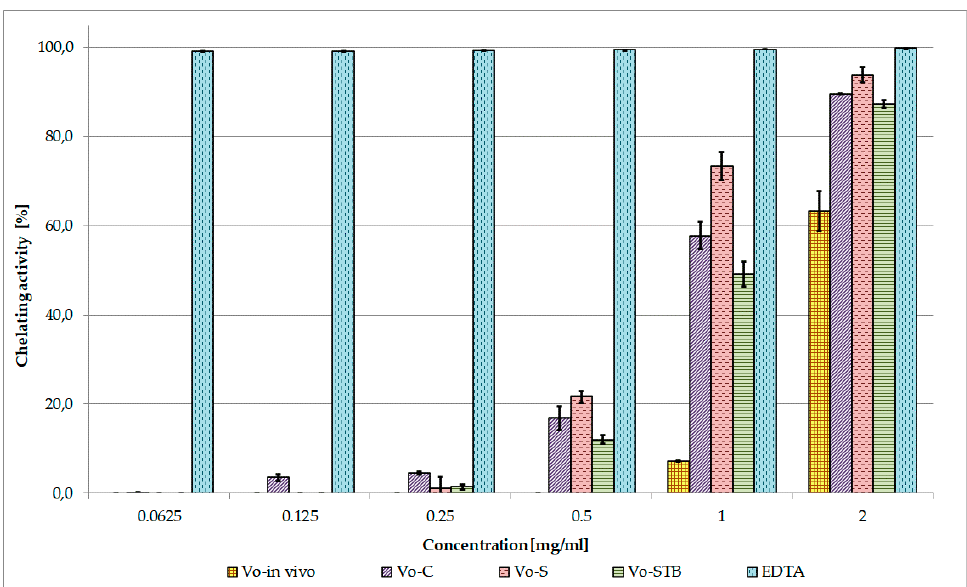
Figure 7. Ferrous ions (Fe 2+ ) chelating activity of V. officinalis extracts. Values are expressed as the mean ± SD (n = 3). Vo -in vivo —V. officinalis parent plant grown in vivo-herb extract; Vo- C— V. officinalis